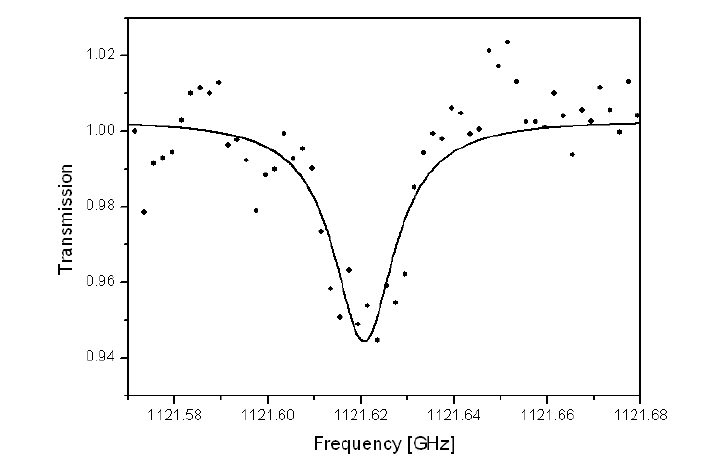
Figure 6 . Measured spectrum of cigarette smoke at a pressure of 2 mbar, a transition of HCOOH is observed with a path length of 20.16 m. Line intensity = 2.2 × 10 –22 cm –1 /(molecule·cm –2 ). The measured datapoints (filled points) are fitted with a Lorentzian absorption profile (solid line).